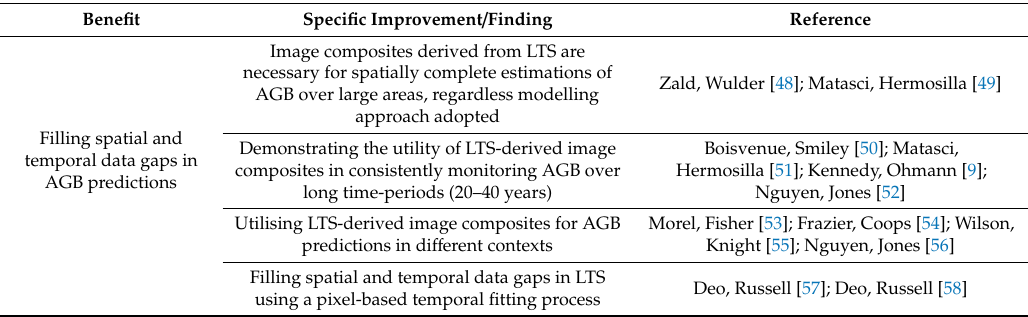
Table 2. Benefits of using LTS to improve the estimation of forest AGB (both single-date and over